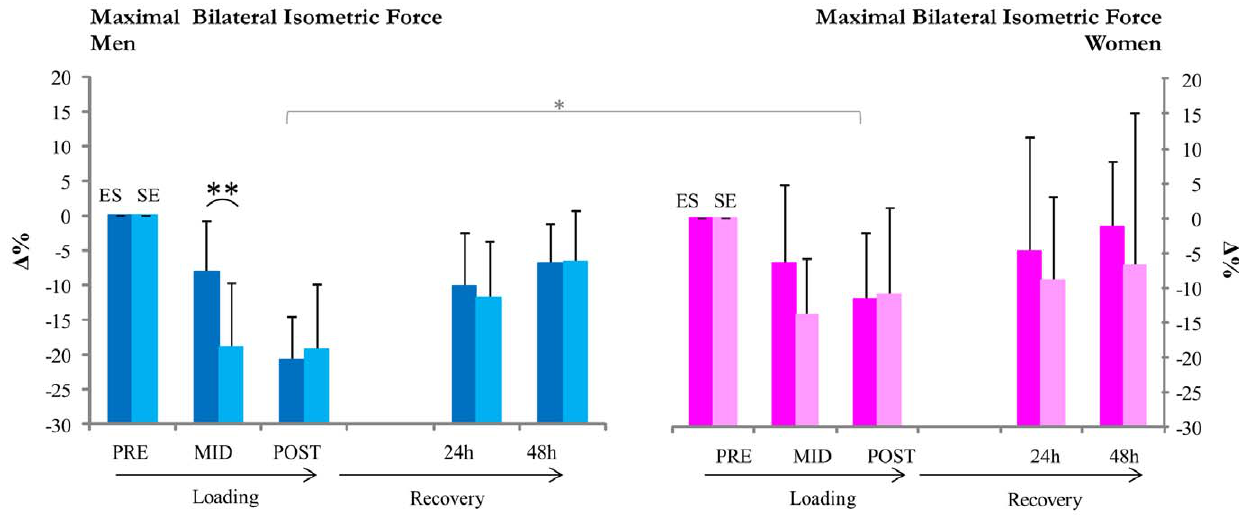
Figure 1. Maximal isometric force. **, *** inside column=significant change (p , 0.01, p , 0.001) in absolute maximal isometric force from pre, +++ =significant change (p , 0.001) in absolute maximal isometric force from mid. **(=p , 0.01 significant differences between relative changes from pre in ES and SE loadings.